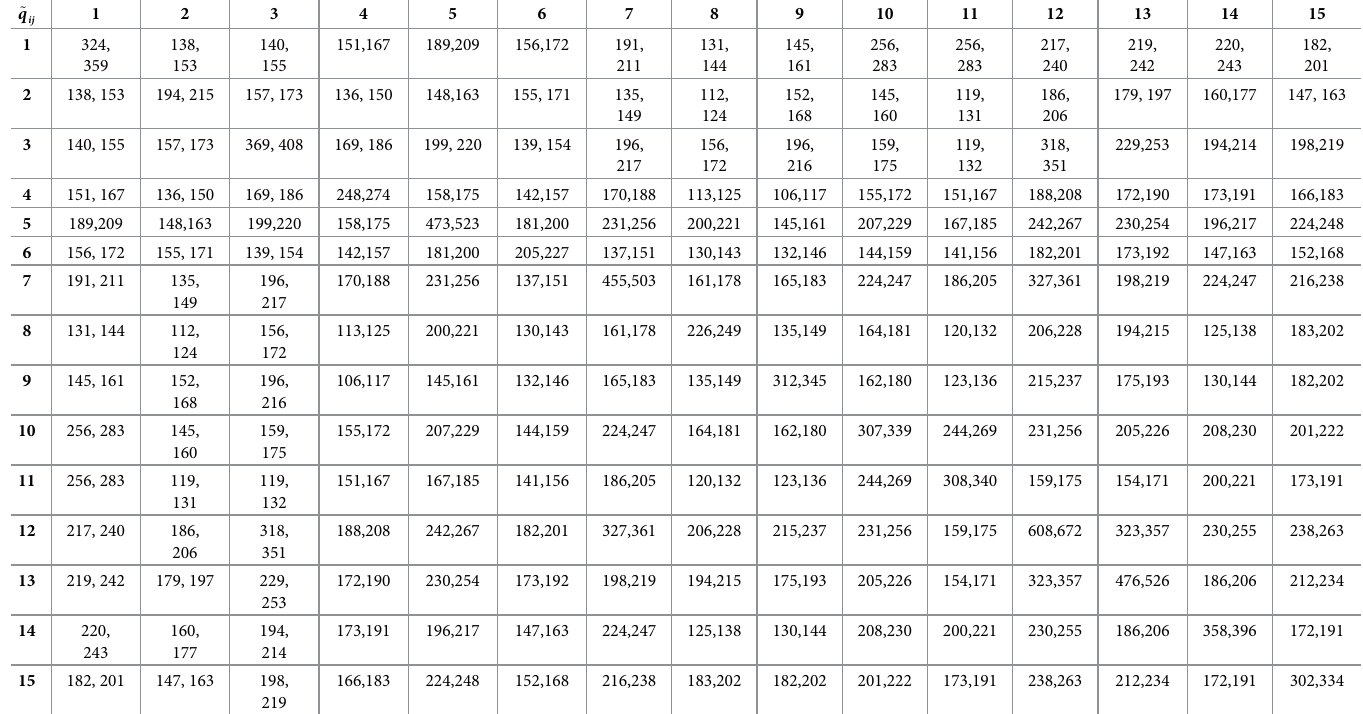
Table 2. The intervals of variance and covariance risk (Unit /10 − 4